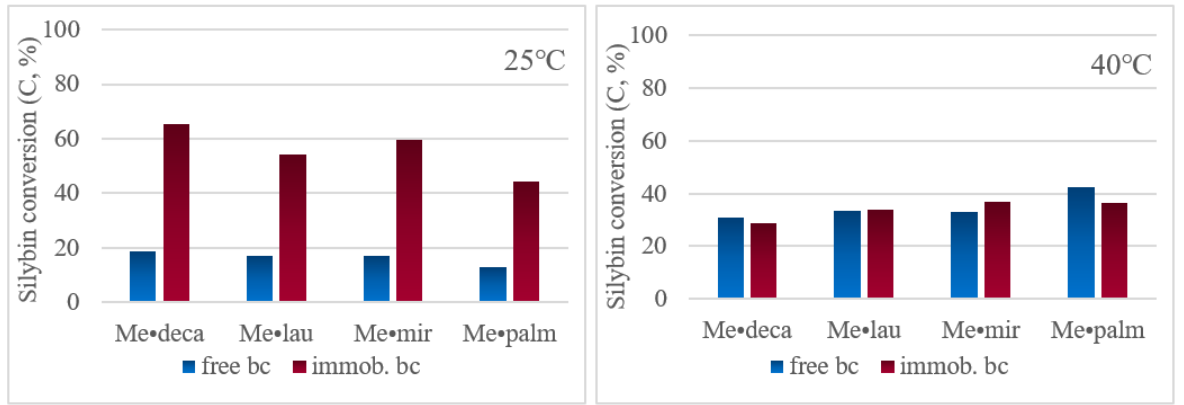
Figure 4. System performance in terms of silybin conversion by using different temperatures: 25 °C and 40 °C, with free lipase ( ■ ) or S5 biocatalyst ( ■ ). Experimental conditions: 2 mM Silybin A/B, 40 mM acylation reagent, 4.72 mg/mL free lipase/4.25 mg/mL S5 biocatalyst in 1 mL THF, at 25 °C or 40 °C and 1000 rpm for 24 h.